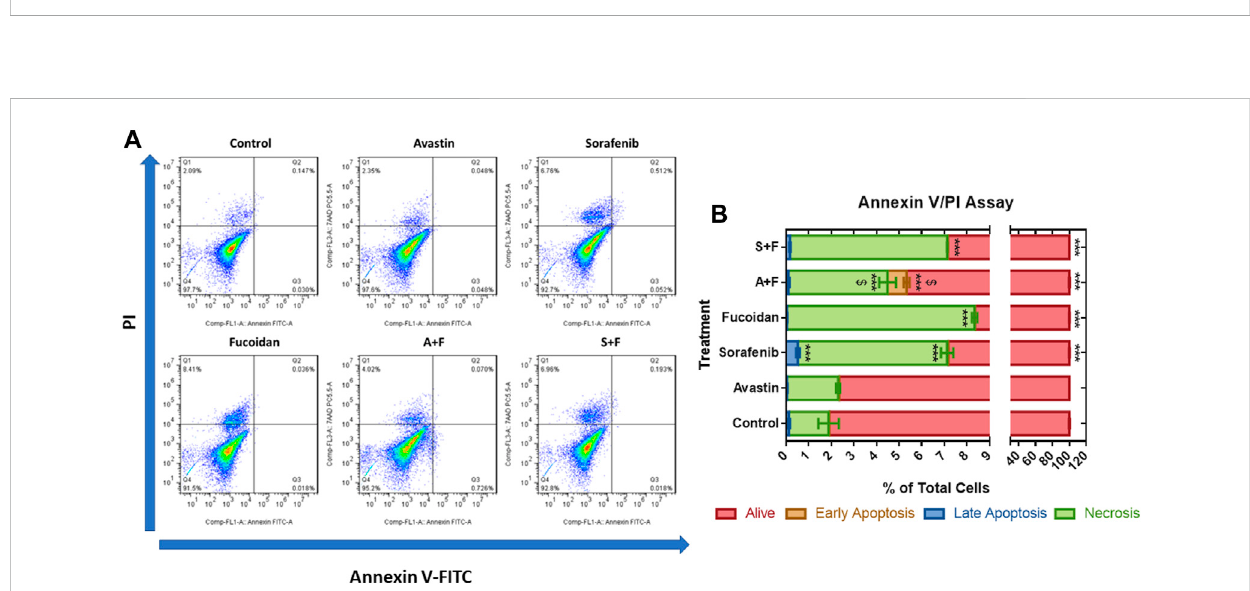
V/PI staining that was measured by fl ow cytometry. In the untreated control and Avastin, 98.1% and 97.66% of the cell population was alive with no signi fi cant difference between both groups. Sorafenib monotherapy caused a signi fi cant increase in the percentage of cells in late apoptosis (0.52%) and necrosis (6.6%) and a signi fi cant decrease in the percentage of live cells